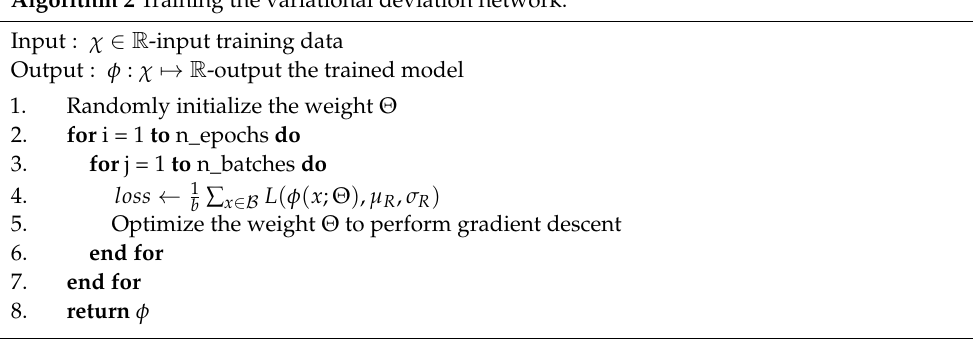
Algorithm 2 Training the variational deviation